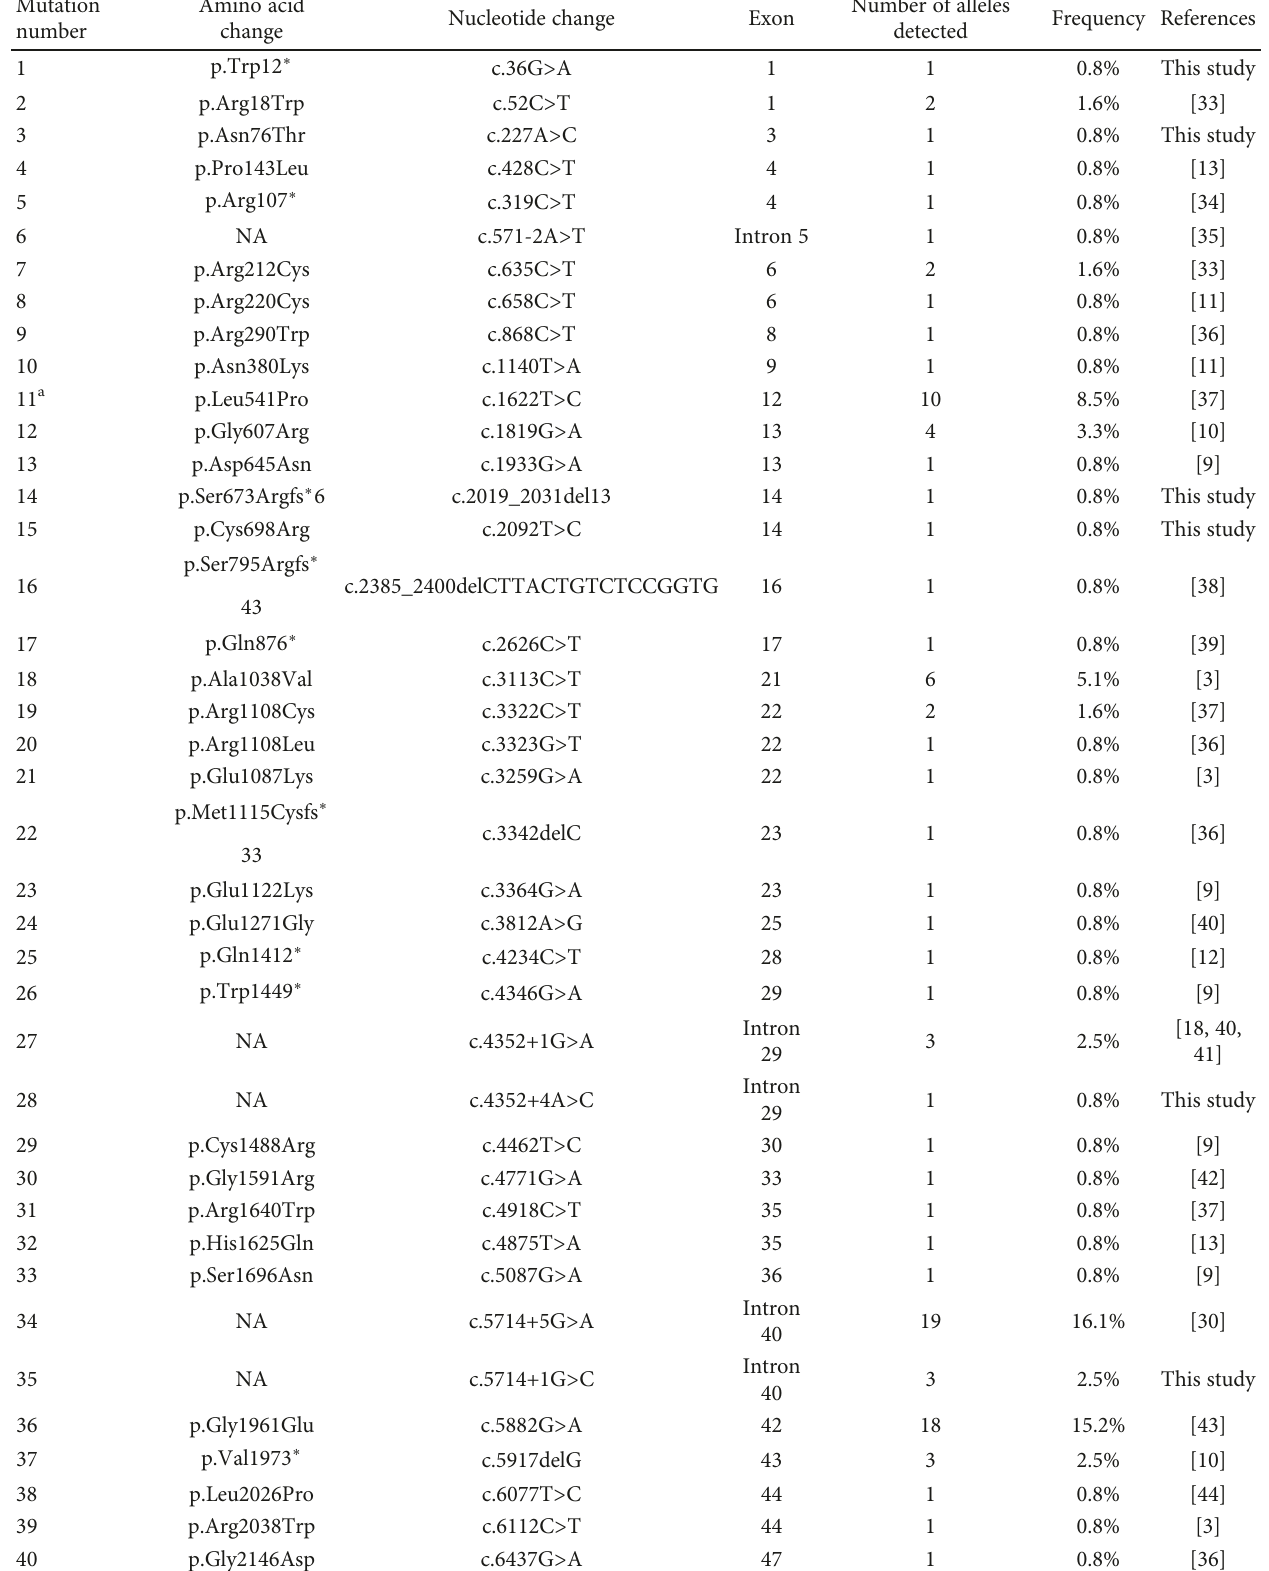
Table 1: Frequency of 40 distinct mutations detected in 59 Greek patients with presumed